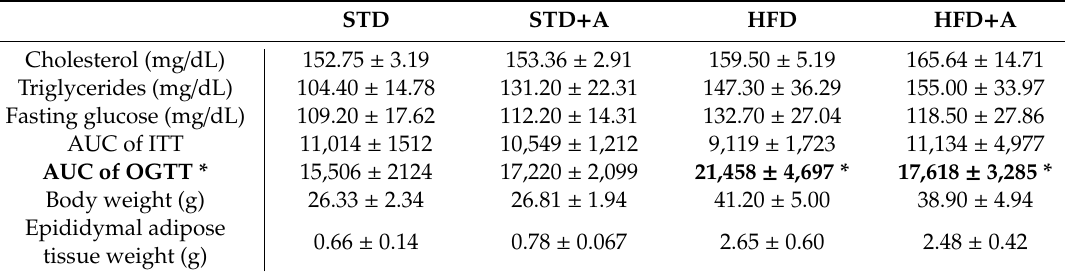
Table 2. E ff ect of alliin on metabolic Table 2. Effect of alliin on metabolic tests.